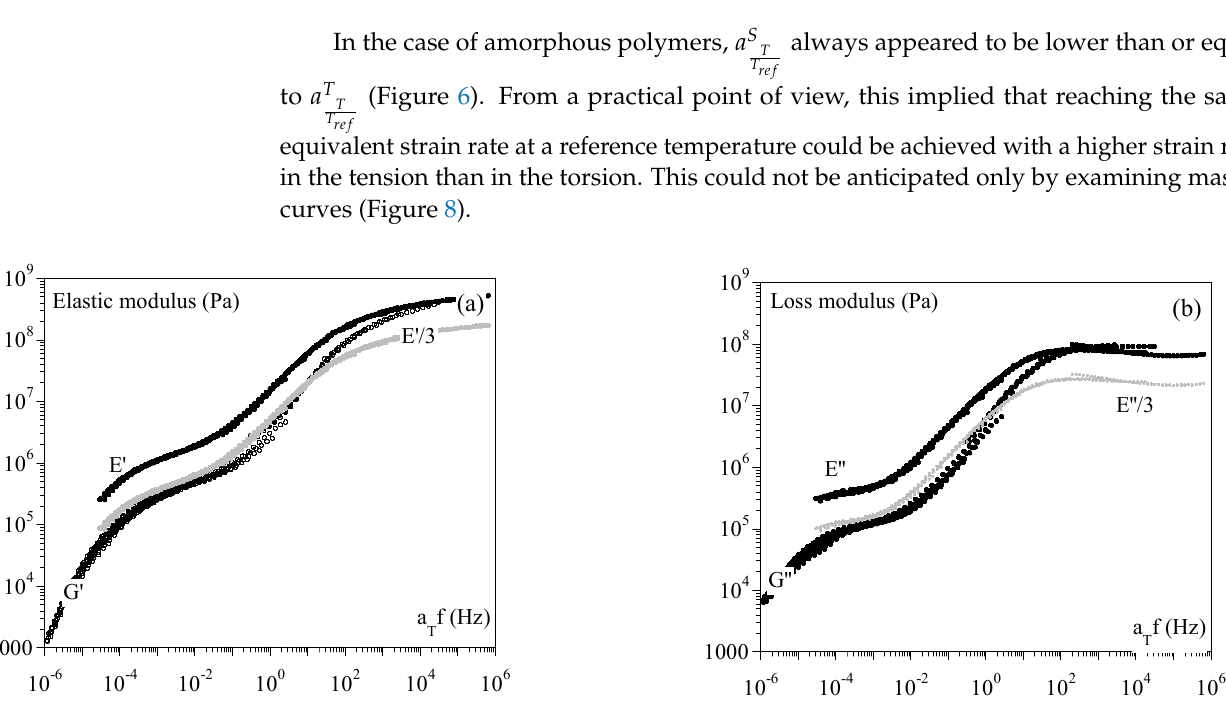
Figure 8. Master curves at 130 °C for PMMA 93. Comparison between torsion (G ′ and G ″ ) and tension (E ′ and E ″ ). Left: elastic moduli; right: loss moduli. Grey curves correspond to estimates of G ′ (resp. G ″ ) from E ′ (resp. E ″ ) while assuming incompressibility ( 𝜐 = 0.5) . ( a ) Elastic modulus; ( b ) Loss mod- ulus.